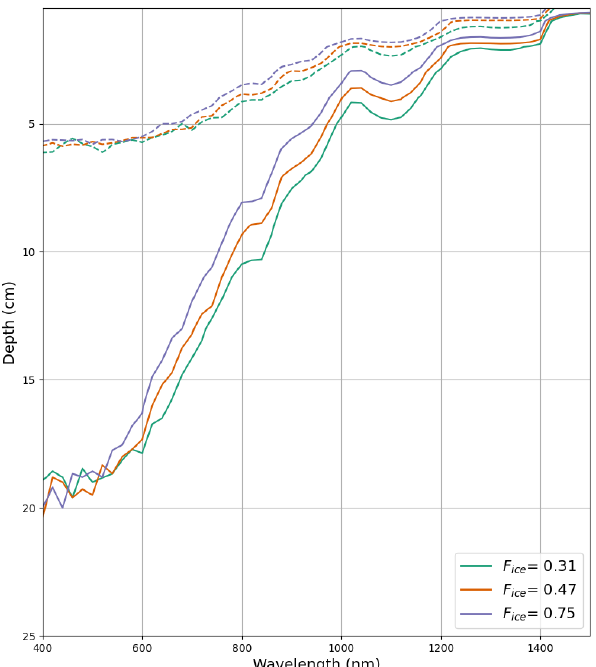
Figure 14. Depth of simulated 5% transmittance contour as a func- tion of the wavelength for varying F ice at two scattering coeffi- cients: γ sca = 0 . 39 (solid lines) and γ sca = 1 . 29 (dashed